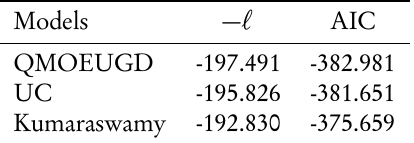
Model selection criteria for QMOEUGD, UC and Kumaraswamy regression